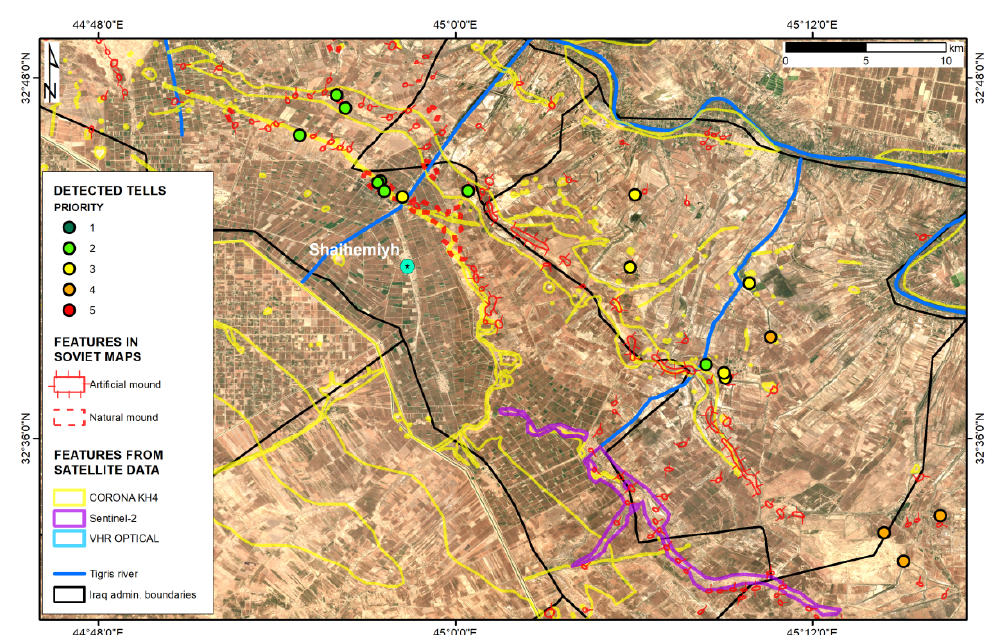
Figure 7. Tell detection through combination of ( a ) VHR optical imagery, ( b ) Sentinel-2 multispec- tral false-colored composite (R: Band 8—NIR; G: Band 4—red; B: Band 3—green), COSMO-SkyMed ( c ) SAR radar backscatter image, and ( d ) DEM with ( e ) height profile drawn along A-A’ section. Products in ( b – d ) were all collected in April 2018, as per Figure 6. Example of small flat mound (Neo-Babylonian to Islamic periods; precise location undisclosed for security concerns) that is de- tected thanks to the DEM only. COSMO-SkyMed ® Products ©ASI, Italian Space Agency, 2018. All rights reserved. Contains Copernicus Sentinel-2 data, 2018.